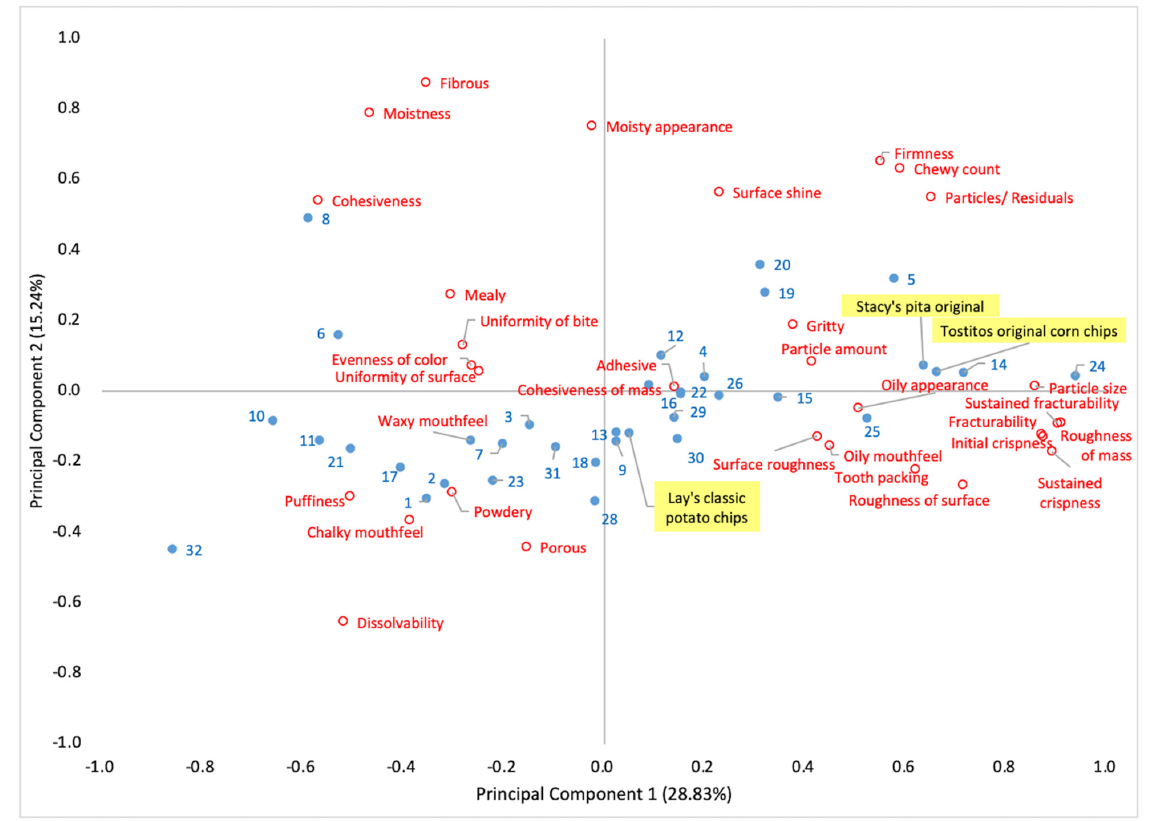
Figure 3. Principal Componensts Analysis ( PCA) plot representing the descriptive texture profiling results of JP snacks. The numbers (including dots) highlighted in blue color represent the snack type as listed in Table 1, and the text (including dots) in red color denotes texture attributes. Three US snacks—Stacy’s pita original, Lay’s classic potato chips, and Tostitos original corn chips (highlighted in yellow color)—were used to compare texture dimensions with JP snacks.